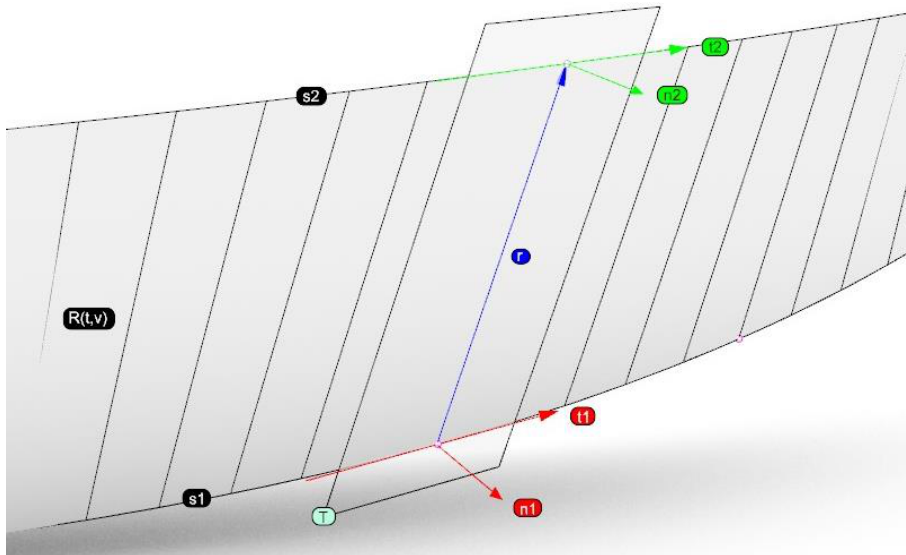
Figure 6. Obtaining a developable surface.